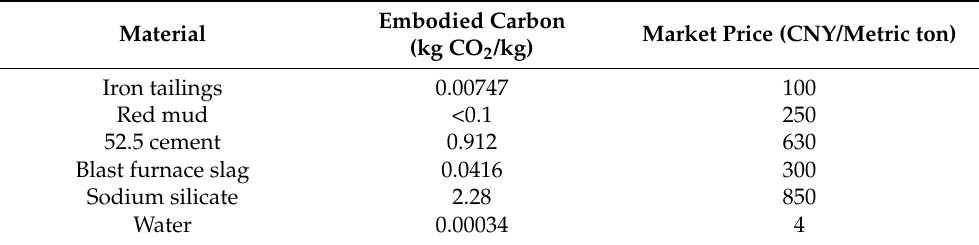
Table 5. Embodied carbon and market price of raw materials.